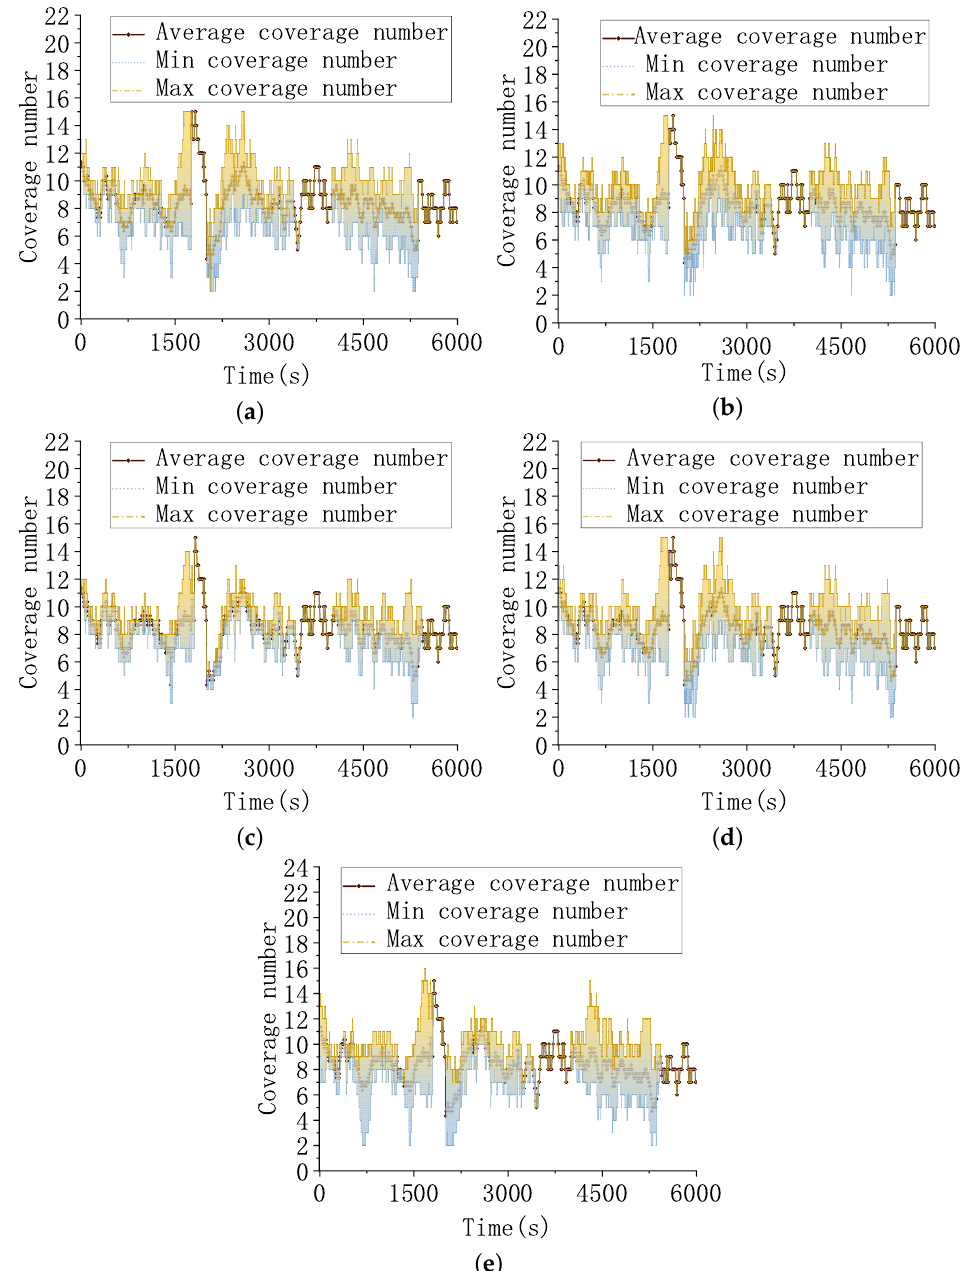
Figure 11. Target covered folds. ( a ) Coverage folds of the MADDPG algorithm for the targets. ( b ) Coverage folds of the MAPPO algorithm for the targets. ( c ) Coverage folds of the MAPPO-RHC algorithm for the targets. ( d ) Coverage folds of the HT3O algorithm for the targets. ( e ) Coverage folds of the HGPT algorithm for the